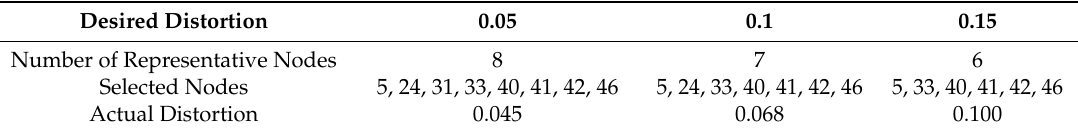
Table 12. The selection of representative nodes and the actual distortion based on a practical calculation (dataset 2 with N = 10